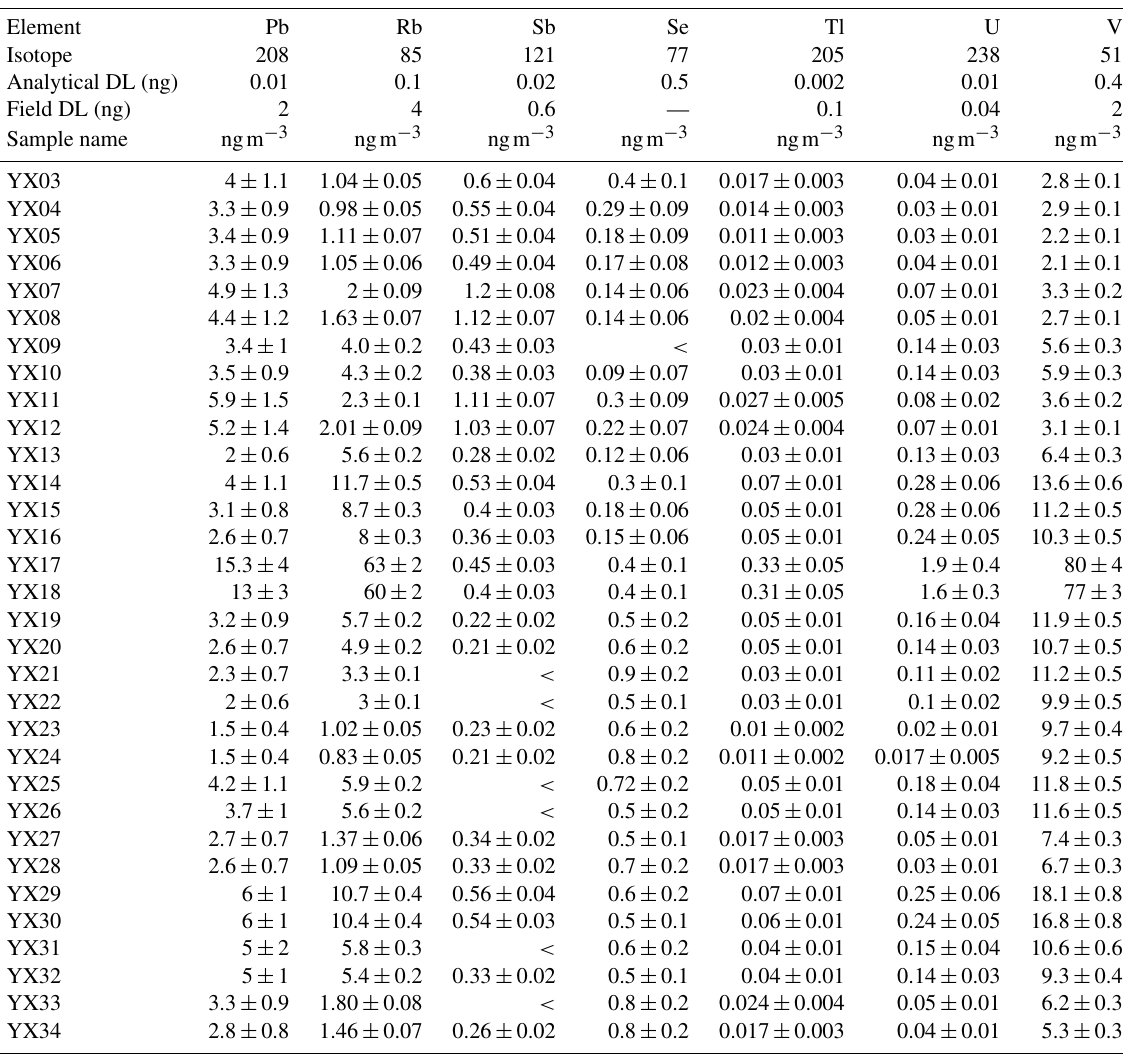
Table A5. Elemental air concentrations measured with ICP-MS,